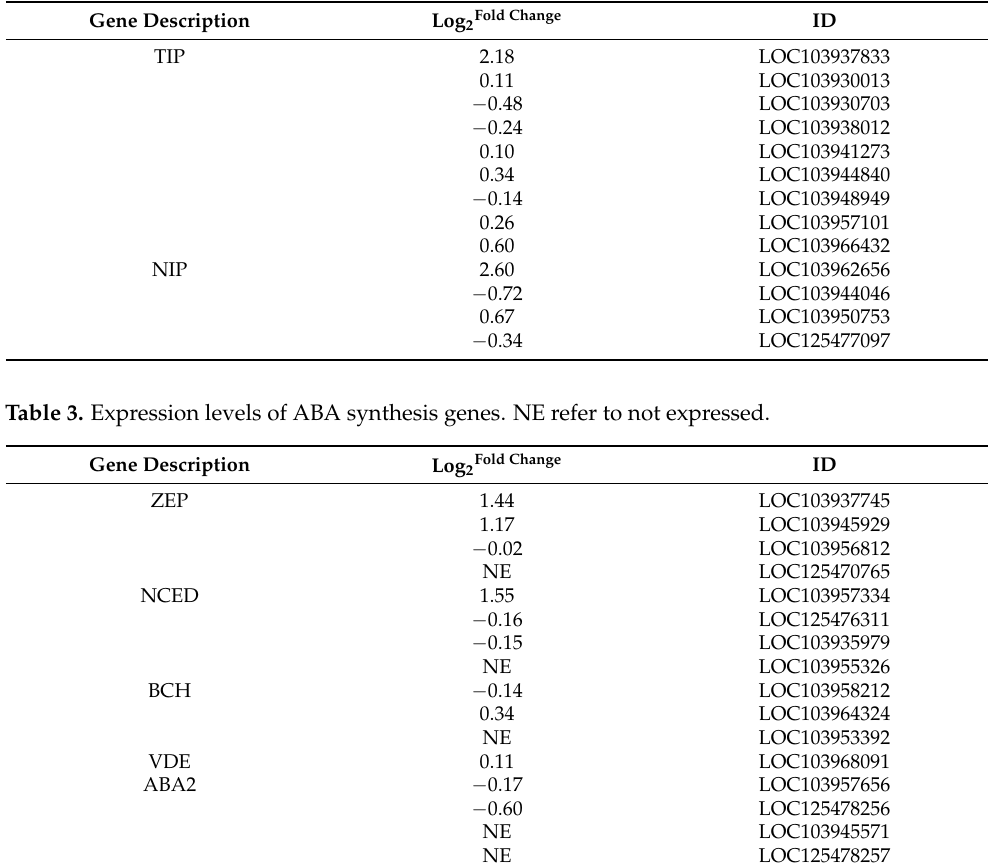
Table 2. Expression levels of aquaporin genes.